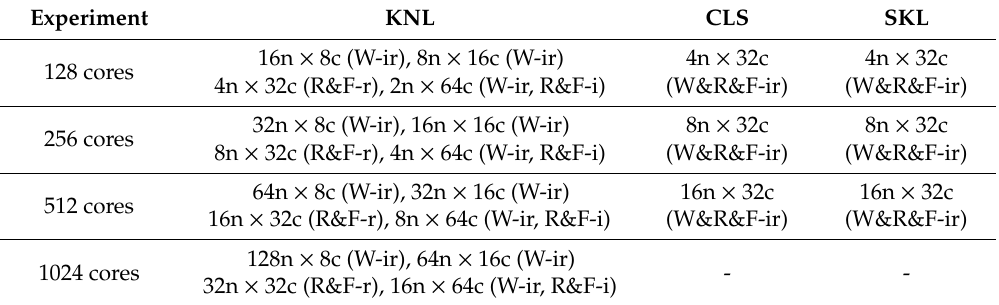
Table 3. Experimental configuration by system (KNL, SKL and CLS) (n: node, c: core, W: Weather Research and Forecasting System (WRF), R: Regional Ocean Modeling System (ROMS), F: Unstructured Grid Finite Volume Community Ocean Model (FVCOM), i: ideal experiment, r: real experiment).